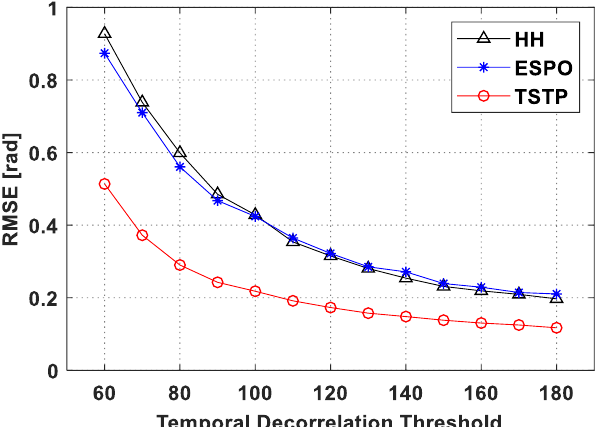
Figure 6. Estimated overall RMSEs of different methods under the number of looks L = 60 and